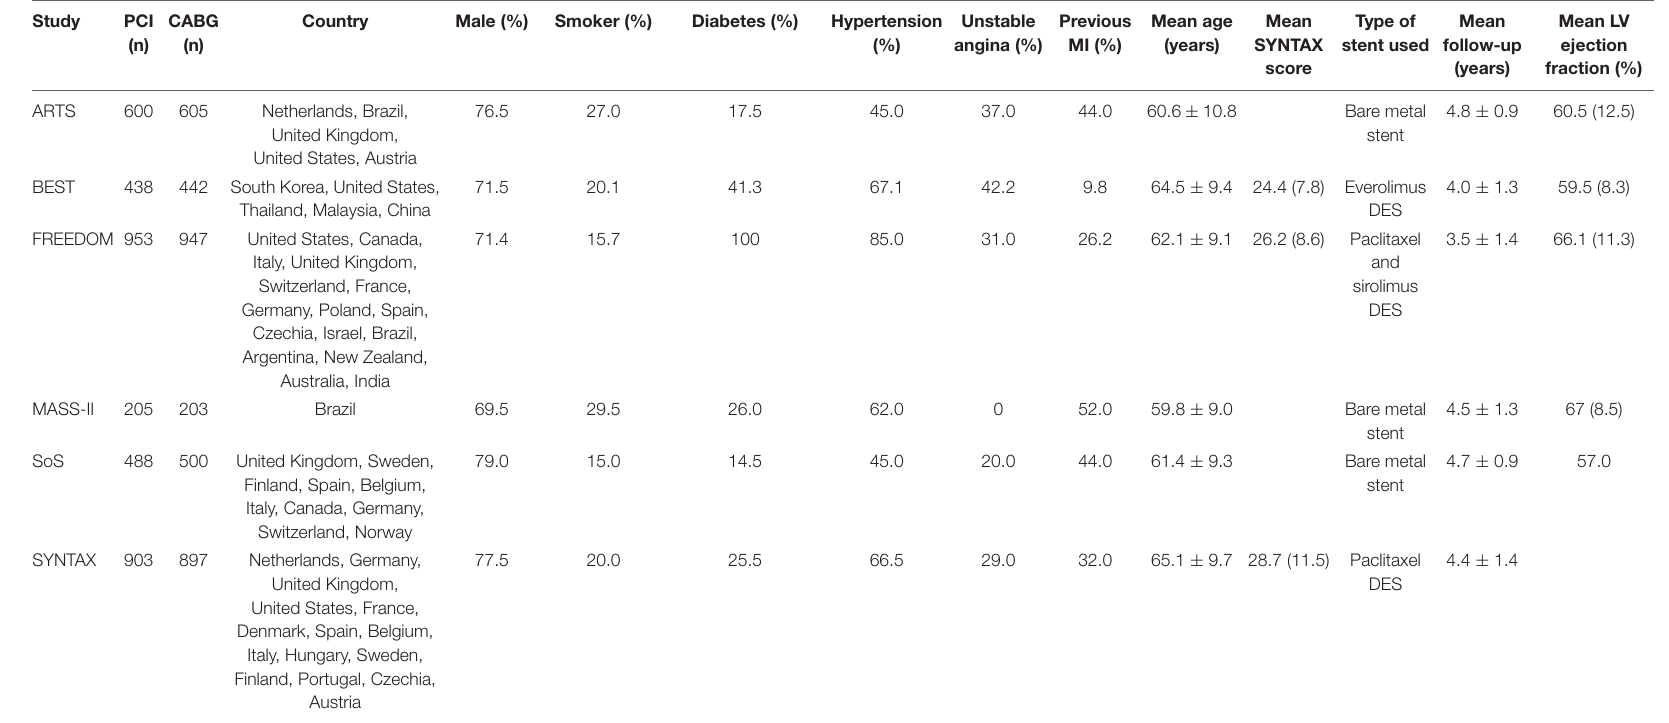
TABLE 1 | Characteristics of included studies.